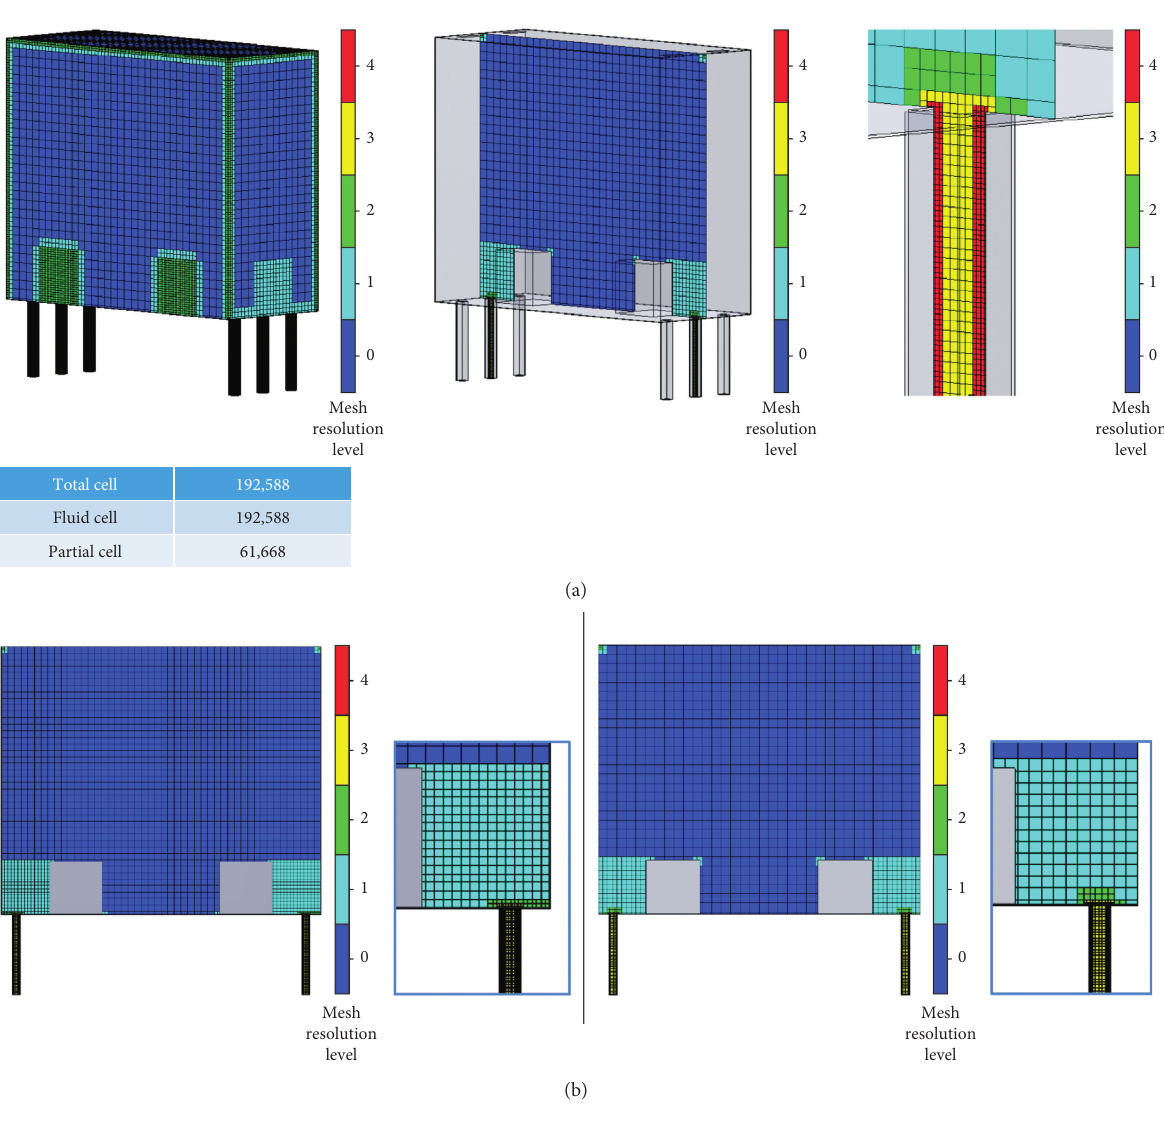
Figure 10: (a) Mesh design for the target facility. (b) Comparison of fine and coarse meshes. Table 6: Case of simulation runtime comparison according to time step (auto step vs. manual step; flow rate: 900